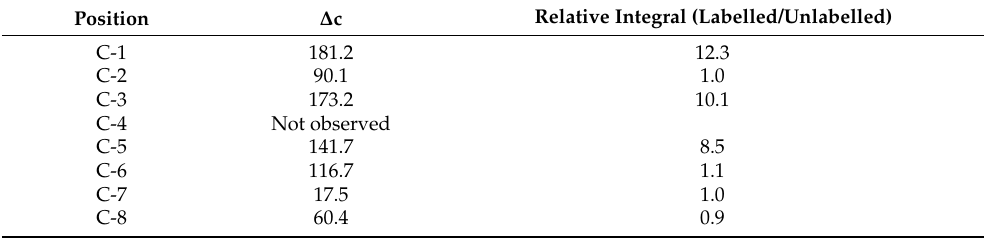
Table 2. Relative Integral Values for 13 C NMR Peaks Observed for 13 C-labelled Penicillic Acid ( 1 ). Position Δc Relative Integral (Labelled/Unlabelled)